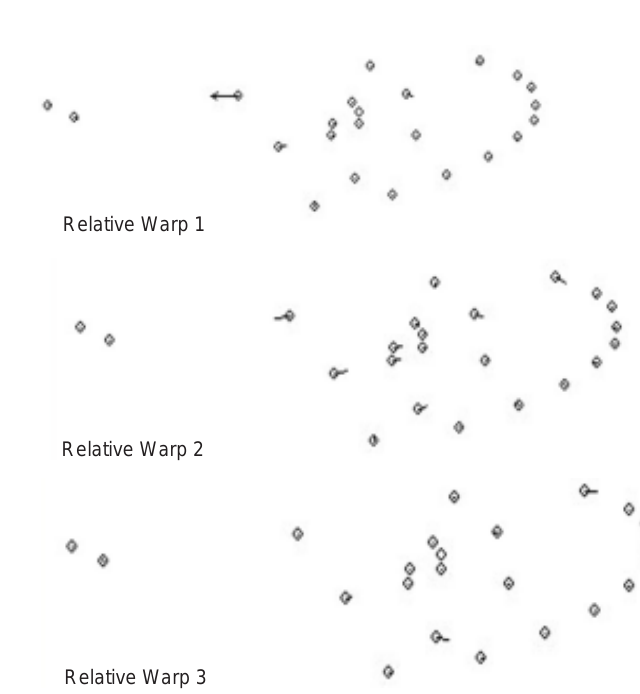
Figure 8 Plots of the relative warp loadings (Alpha = 0) and the grid of the wings superimposed in the reference configuration based on affine generalised resistant fit (Alpha =